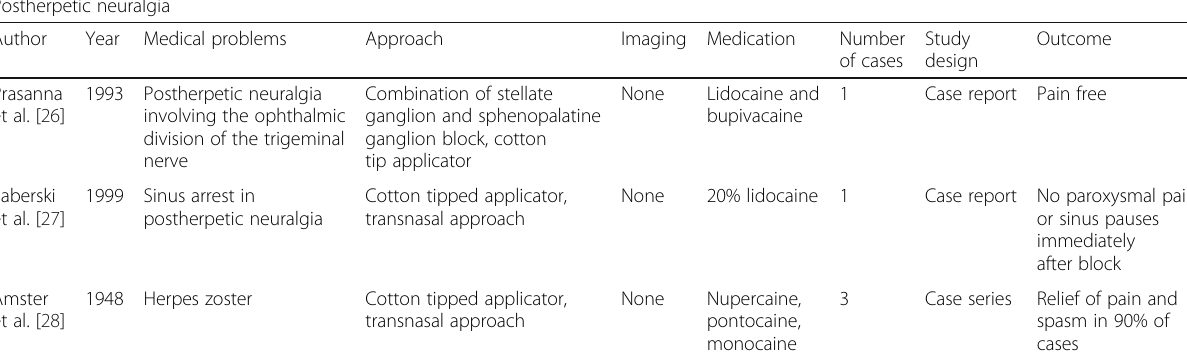
Table 8 Studies of SPG block on postherpetic neuralgia Postherpetic